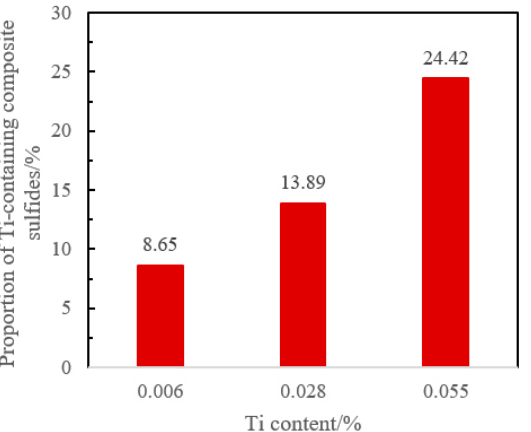
Figure 8. The proportion of Ti-containing composite sulfides in total sulfides in steels with different Ti contents in as-cast samples.